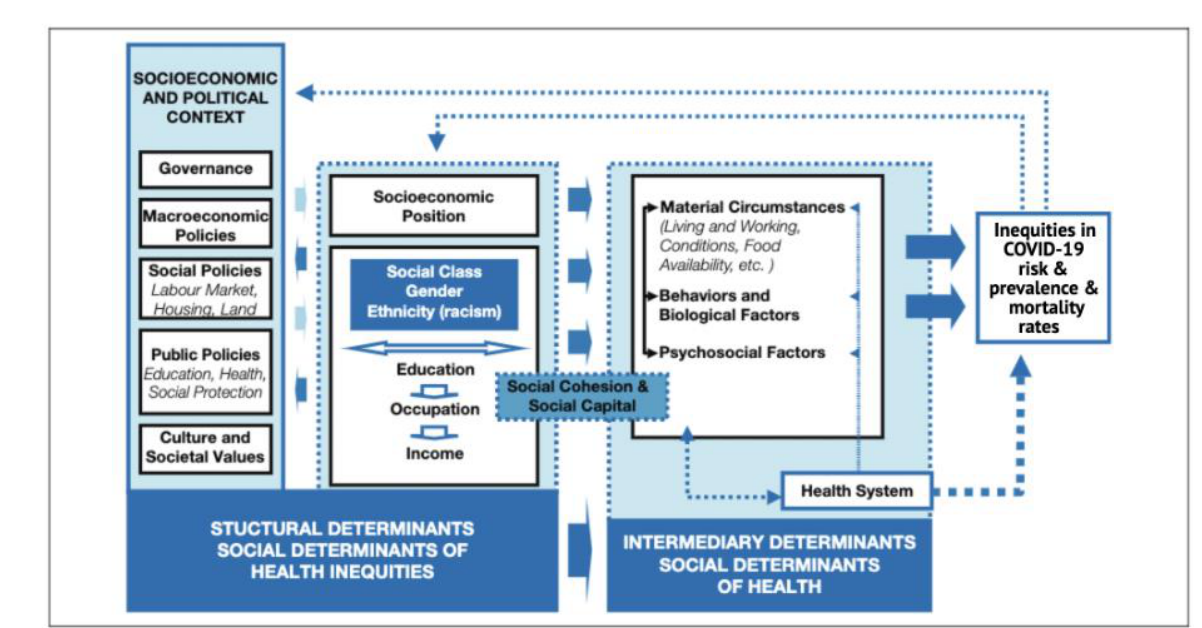
Figure 2. Adapted conceptual framework for action on the social determinants of health, 2010. Data source: World Health Organization [8] ().